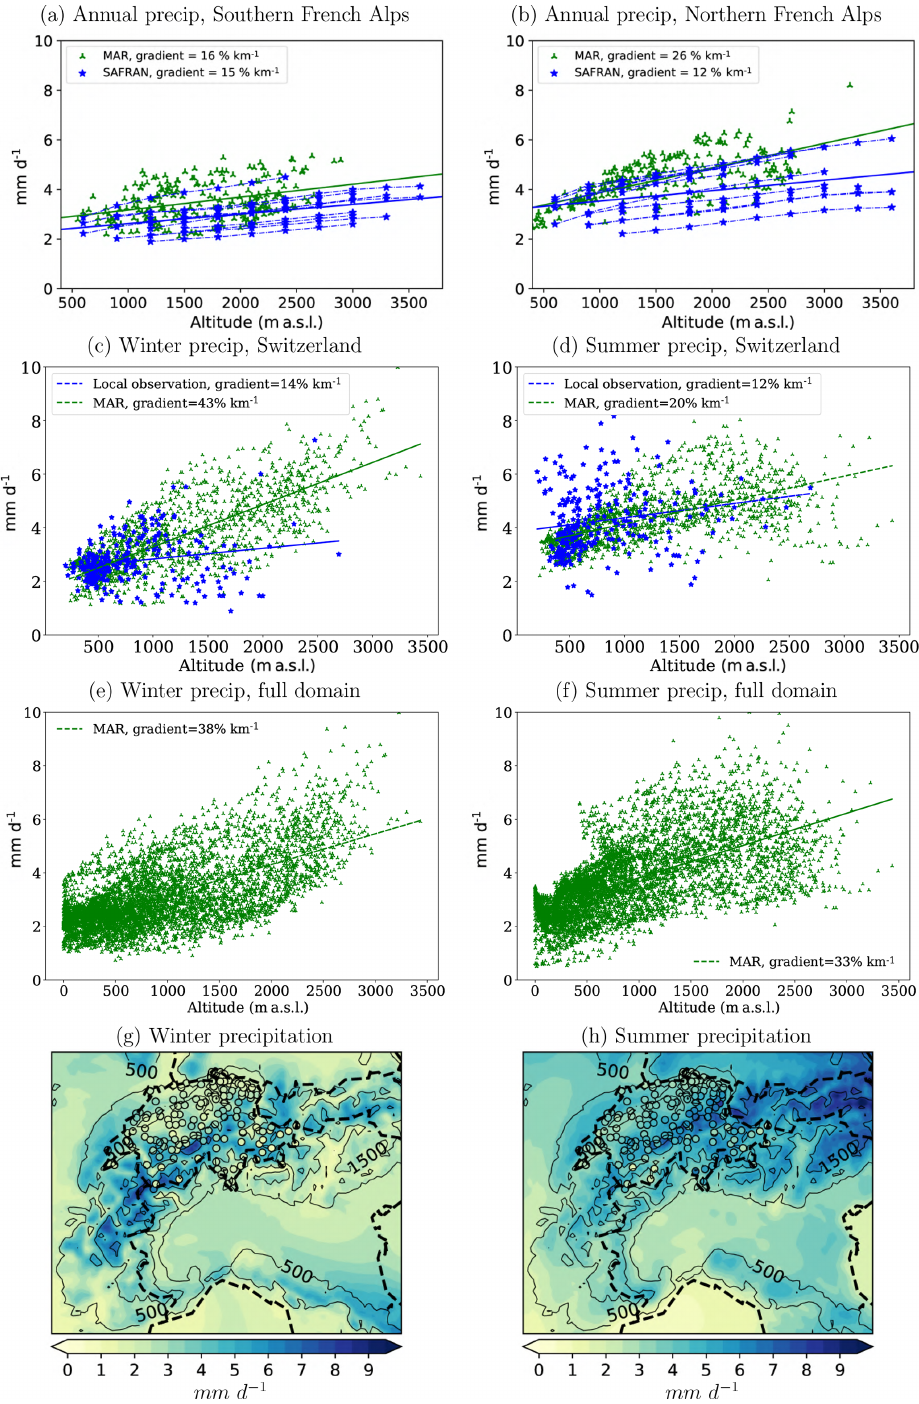
Figure 2. Precipitation (STP) averaged over 1971–2008 simulated by MAR and estimated from reanalyses and observations. Panels (a– f) show precipitation as a function of the elevation over the southern (a) and the northern (b) French Alps in MAR experiments and S2M reanalysis and estimated over Switzerland from local meteorological stations and from the MAR grid cells covering Switzerland during summer (c) and winter (d) . The vertical gradients averaged over the whole model domain are shown for winter (e) and summer (f) . STP averaged over 1903–2010 in the MAR experiment (shaded, mmd − 1 ) and observed at MeteoSwiss stations in Switzerland (dots, observations available from the beginning of the 20th century) are shown for summer (g) and winter (h) . In (g) and (h) , the 1000m spaced black contours show the topography with a 7km resolution, starting from 500ma.s.l., and political frontiers are denoted with the black dashed